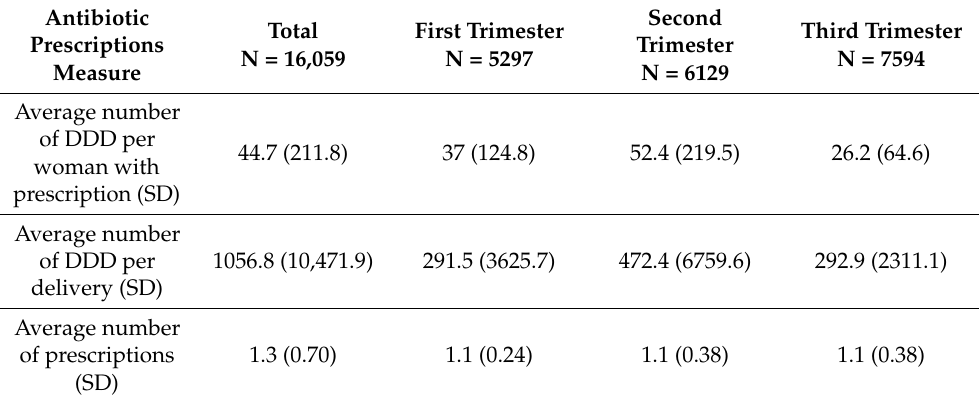
Table 1. Number of antibiotic prescriptions and DDD (defined daily doses), according to trimesters.